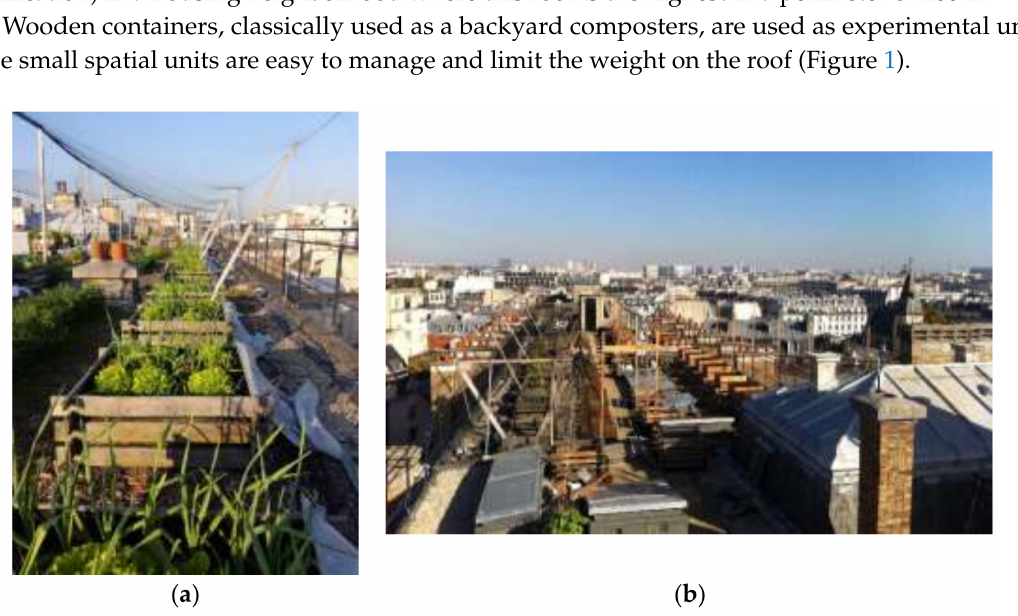
Figure 1. ( a ) Pictures of the T4P experimental devices in April 2017. ( b ) the experimental devices. Source B.